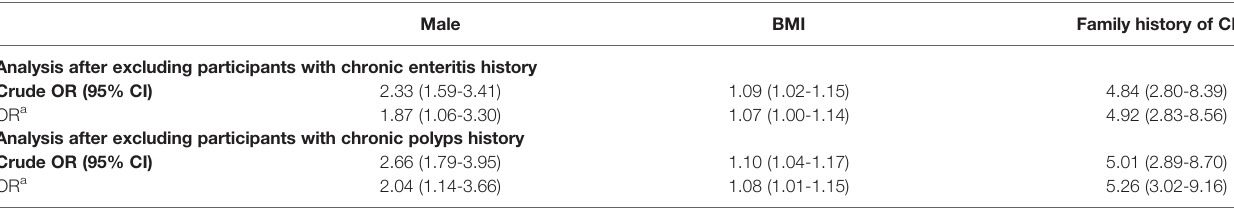
TABLE 3 | Sensitivity analyses of the risk factors associated with early-onset colorectal neoplasm. Male BMI Analysis after excluding participants with chronic enteritis history Crude OR (95%